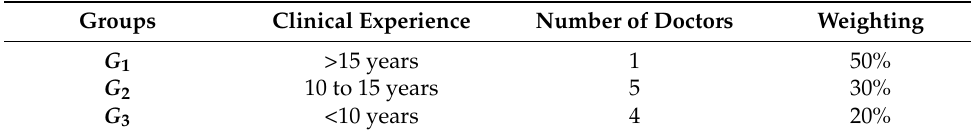
Table 8. The number of the ten doctors in three categories. Groups Clinical Experience Number of Doctors Weighting